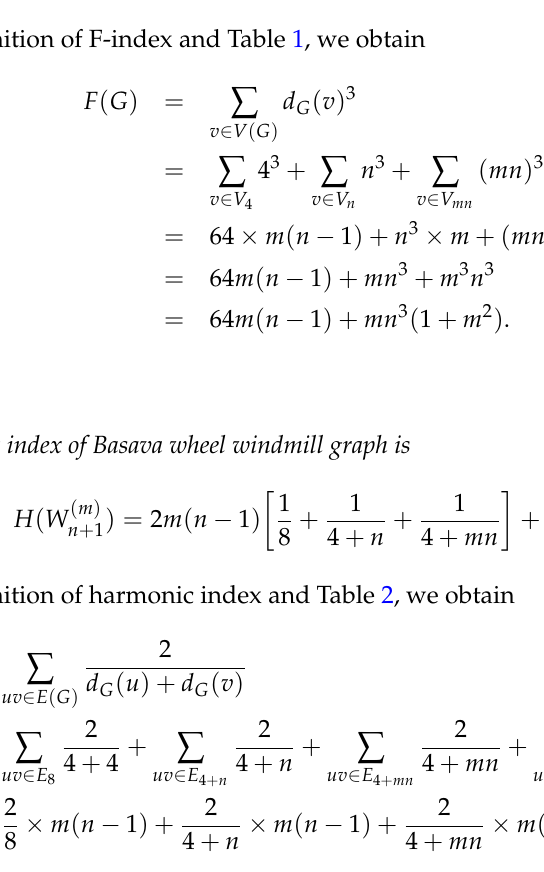
Figure 1. Basava wheel windmill graph W